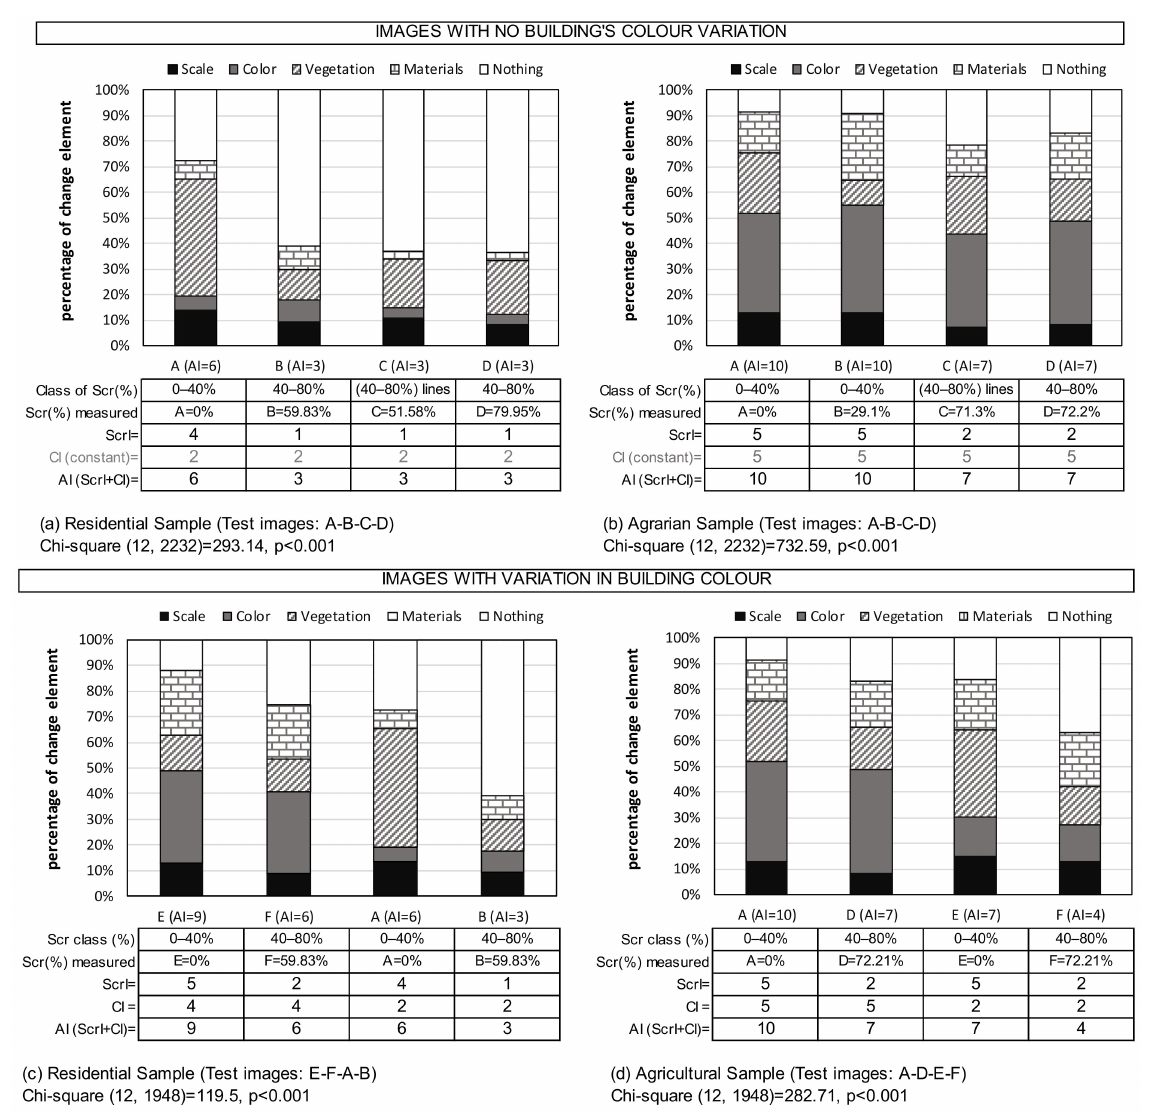
Figure 7. Results of preferences in change elements for images with no building colour variation: ( a ) Residential Sample: test images: A-B-C-D, (Figure 3) and ( b ) Agrarian Sample, test images: A-B-C-D, (Figure 4). Results of preferences in change elements for images with variation in building colour: ( c ) Residential Sample: test images: E-F-A-B, (Figure 3) and ( d ) Agrarian Sample, test images: A-D-E-F, (Figure